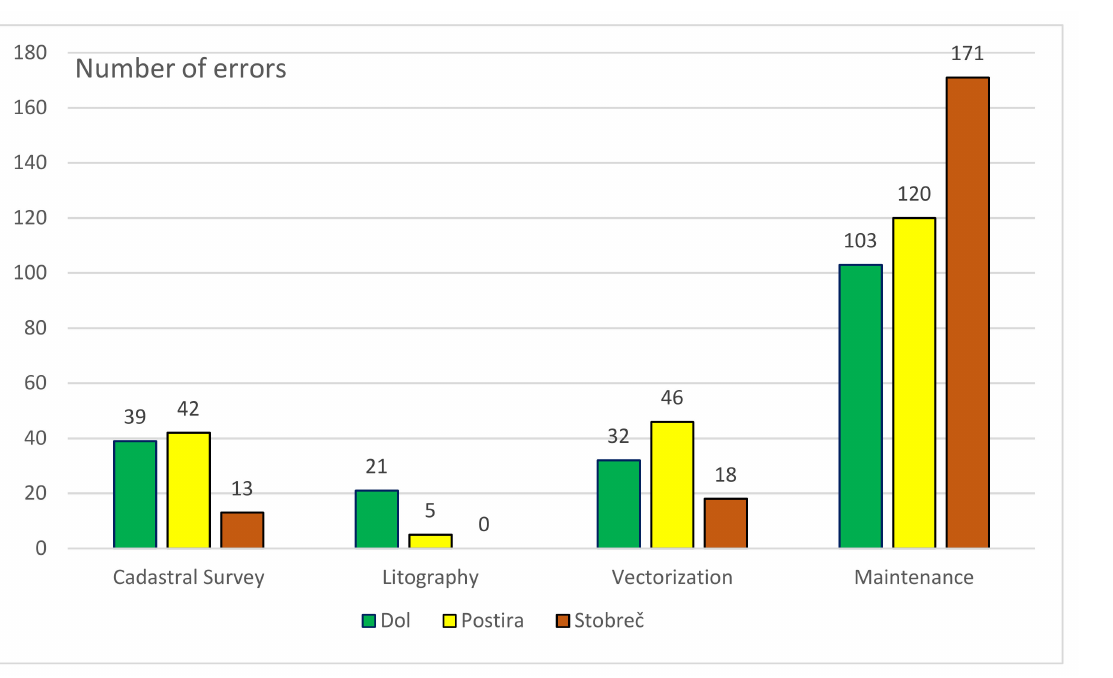
Figure 4. Inconsistency origins by cadastral municipality. Source: own